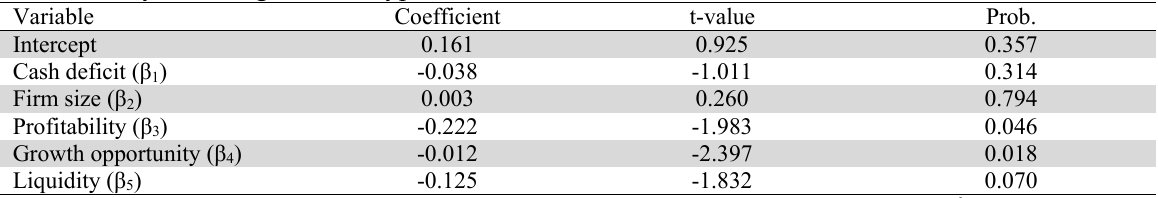
The summary of testing the first hypothesis Variable